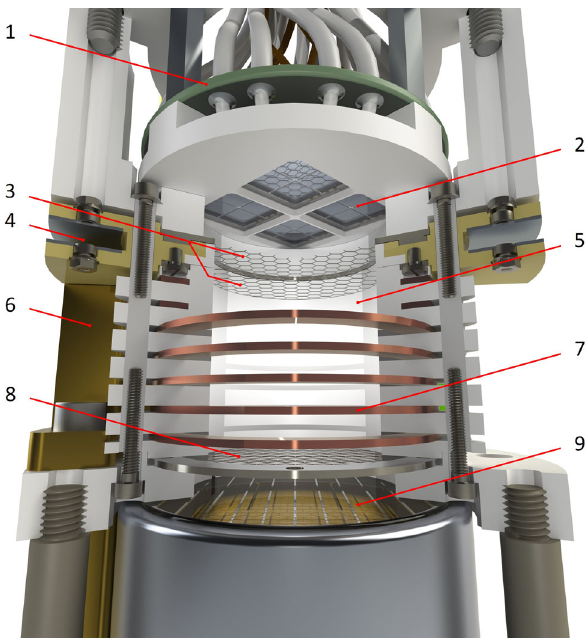
Fig. 1 Rendering of the upgraded Xurich II TPC. The active liquid xenon (LXe) is contained within a PTFE cylinder and surrounded by copper field-shaping rings. A 2-in. PMT is placed in the liquid, and an array of 16 SiPMs is placed in the gaseous phase at the top. For the sake of visualisation, two field-shaping rings have been cut. Legend: 1 – PCB with × 10 preamplifier, 2 – SiPM array, 3 – Anode and gate mesh, 4 – Level meters, 5 – PTFE reflector wall, 6 – Weir for liquid level control, 7 – Copper field-shaping rings, 8 – Cathode, 9 – PMT